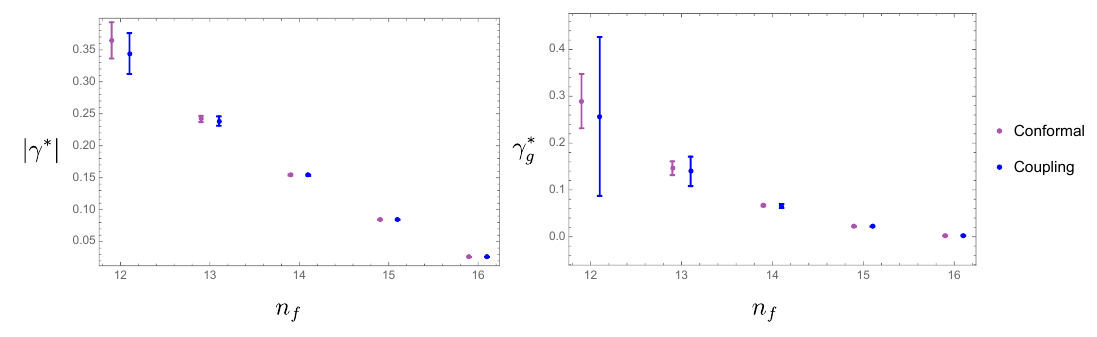
Figure 8 . The (cid:12)xed point coupling as a function of n f in QCD. The central values and error bars refer to the Pad(cid:19)e-Borel approximants [1 = 2] in the conformal expansions and [2 = 2] in the coupling expansion. For both ordinary coupling and conformal expansions the error bars correspond to c np = 10.